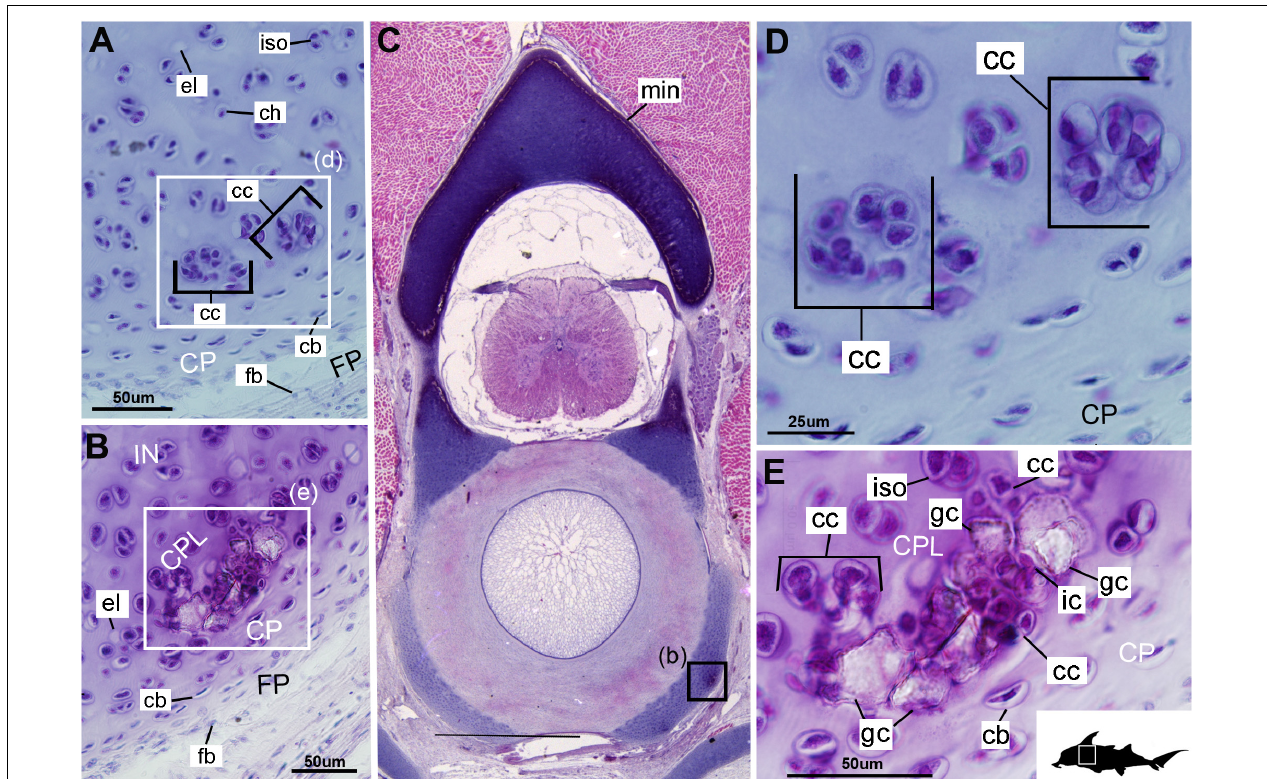
FIGURE 3 | Histological sections through the posterior synarcual (anterior fused vertebrae) of a stage 36 embryo of Callorhinchus milii (Holocephali; Callorhinchidae). (A,B) Closeups showing initial mineralization in a basiventral and clustered chondrocytes in the same location in the preceding section; (C) overview with location of closeup view of initial mineralization indicated by a black square; (D,E) close ups of (A,B) locations indicated by white squares. Abbreviations: As in previous figures, also dm, developing mineralization. Black silhouette of C. millii indicates approximate region shown in the